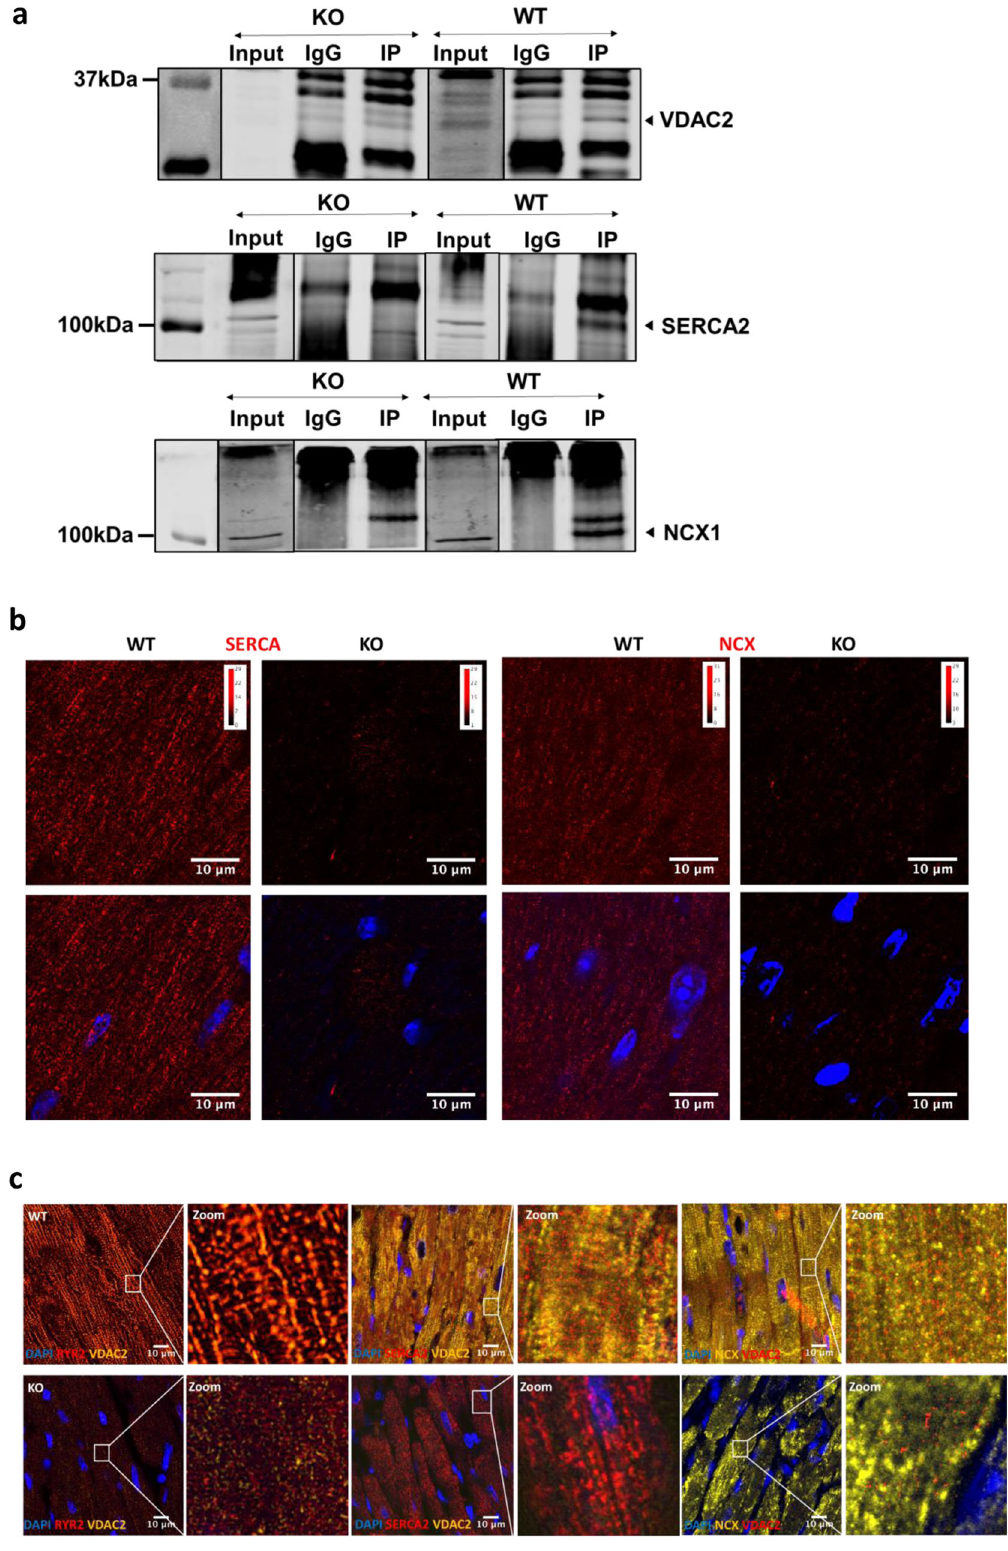
Fig. 4 Cross-talk between mitochondria and ER/SR facilitates mitochondrial calcium cycling. a Representative co-immunoprecipitation image from a cardiac ventricular sample of 8-week-old mice ( n = 3) in WT and KO (Input — non-IP sample; IgG — control antibody; IP — VDAC2 protein pull-down); b Representative proximity ligation assay image for VDAC2 – SERCA2 and VDAC2 – NCX1 interaction in 8-week-old mice (scale bar, 10 μ m) ( n = 3); c Representative immuno fl uorescence image from 16-week-old mice heart (scale bar, 10 μ m) ( n =